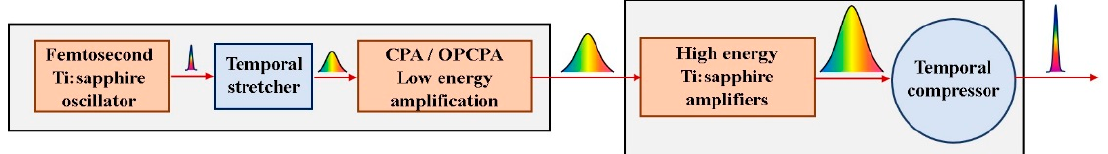
Figure 18. Schematic configuration of a hybrid chirped pulse amplification laser system.